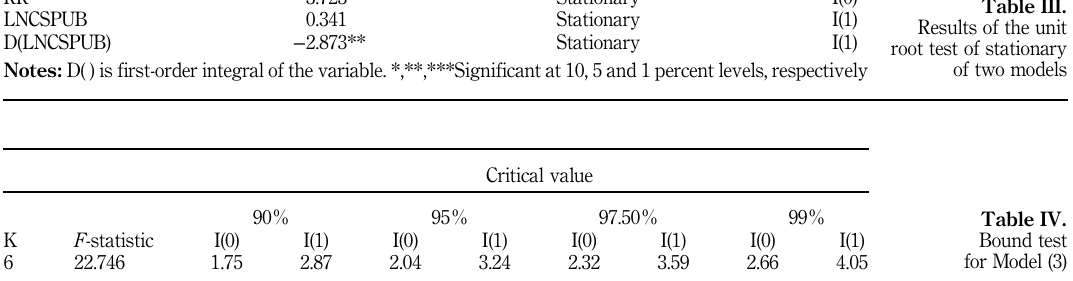
Table IV. Bound test for Model